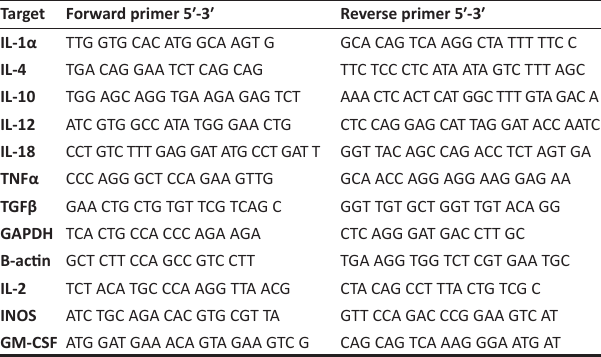
TABLE 1-A1: Rotor-gene Q ovine quantitative real time polymerase primers used to quantify cytokine mRNA targets in quantitative real time polymerase chain reaction assay.